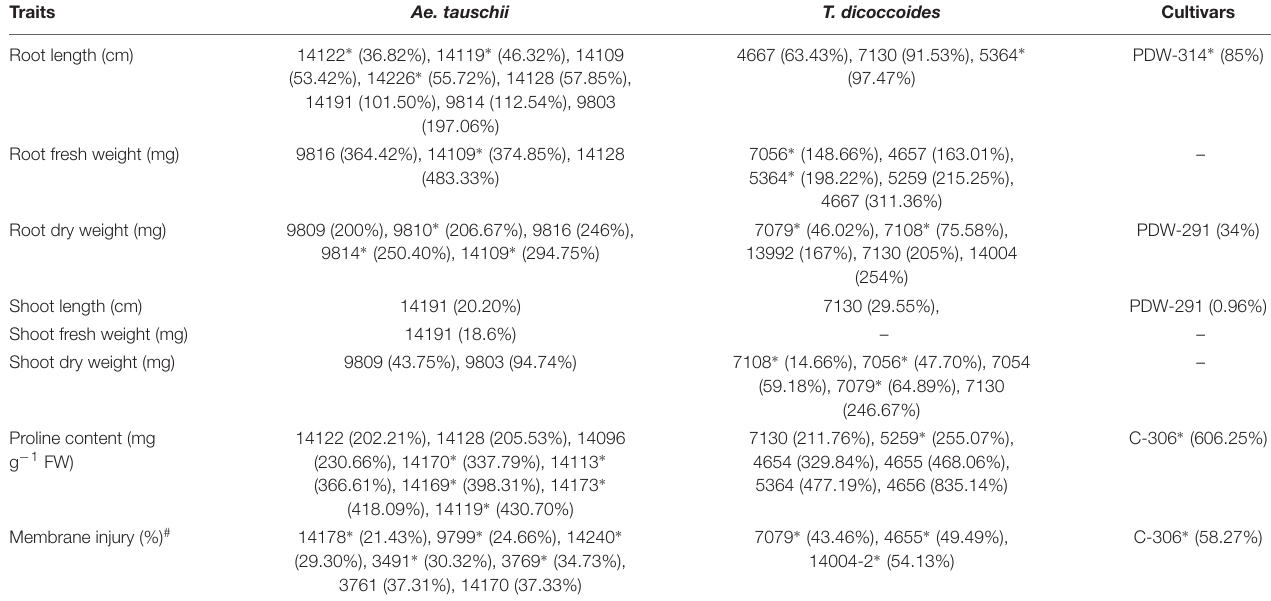
TABLE 3 | Genotypes showing high levels of plasticity for different morpho-physiological traits across well watered and water stress conditions. Traits